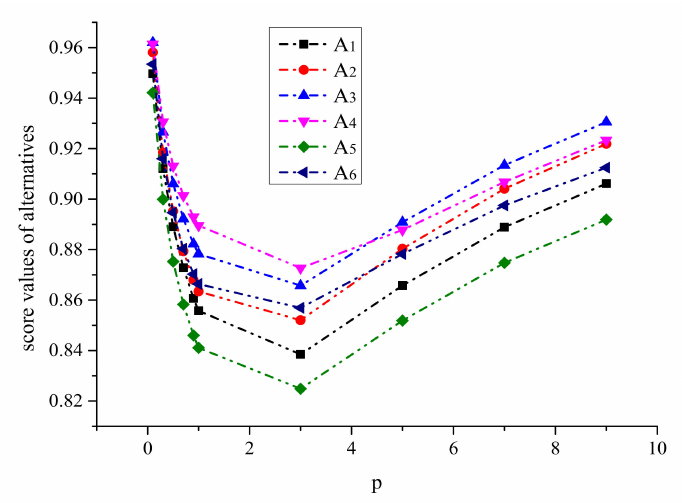
Figure 8. Alternatives ranking with q = 2) when p , q ∈ [ 0.1,9 ] .